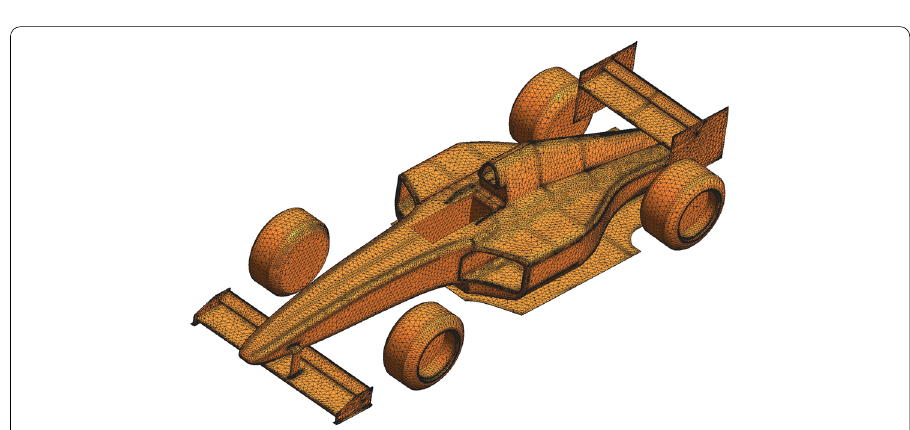
Fig. 38 STL model of a racing car representing a complex geometry including surface and volume areas at different length-scales in all its details within the background mesh, see Fig. 39b, c. The resulting number